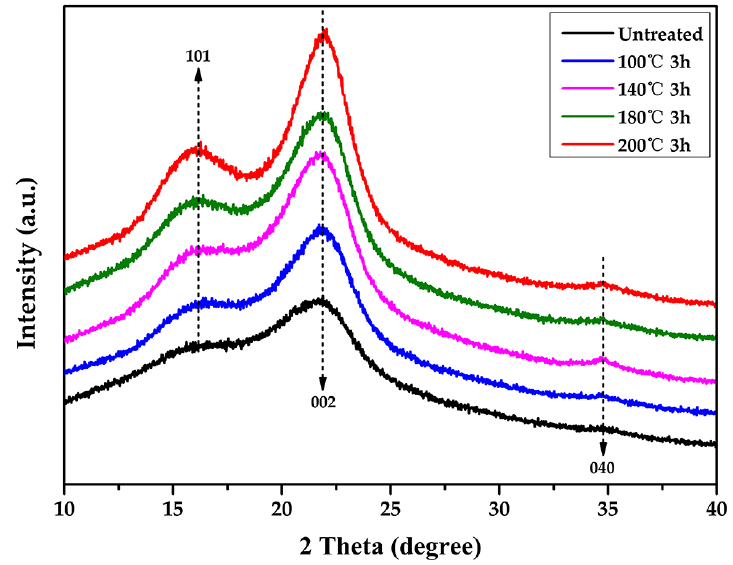
Figure 6. XRD patterns of moso bamboo.